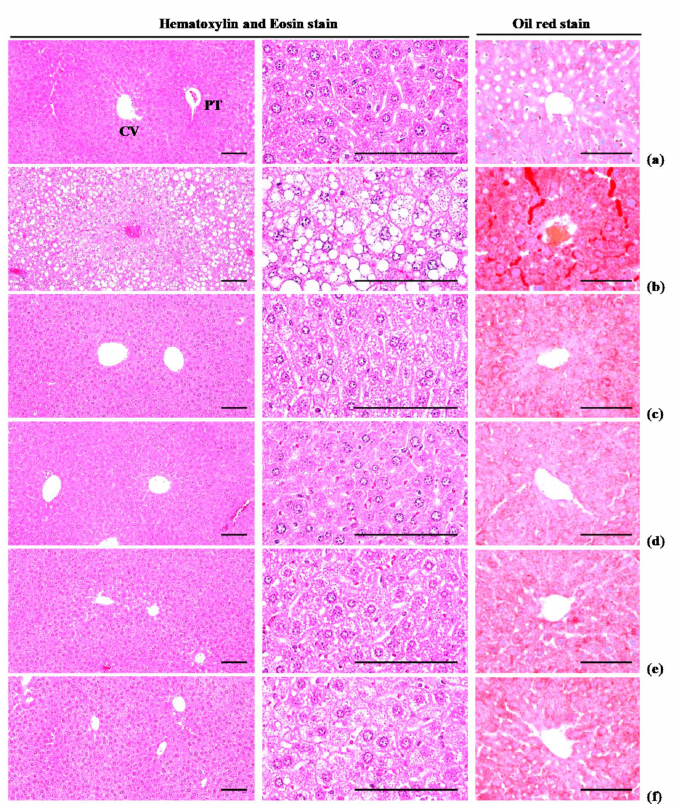
Figure 9. Representative histological images of the liver, taken from NFD or HFD supplied mice. ( a ) Vehicle (distilled water) 10 mL / kg orally administered mice with NFD supply (Intact